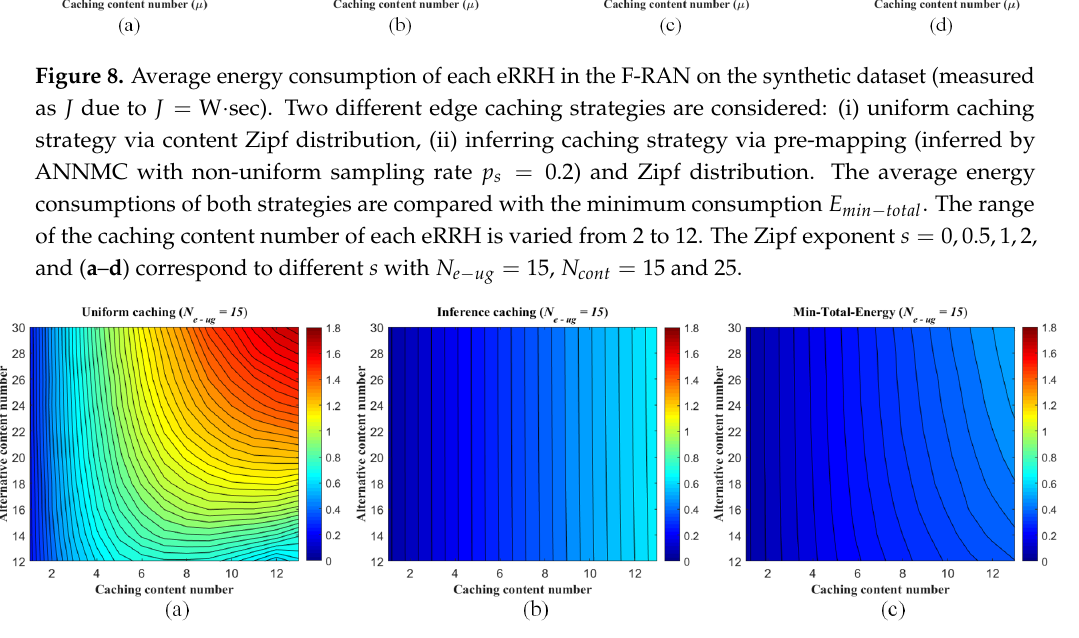
Figure 9. Average energy consumption range of each eRRH in the F-RAN on the synthetic dataset (measured as J ) with the setting that N e − ug = 15 and Zipf exponent s = 0.5. ( a ) is the uniform caching strategy via content Zipf distribution; ( b ) is the proposed inferring caching strategy via pre-mapping (inferring by ANNMC with non-uniform sampling rate p s = 0.2) and Zipf distribution; ( c ) is the minimum consumption E min − total